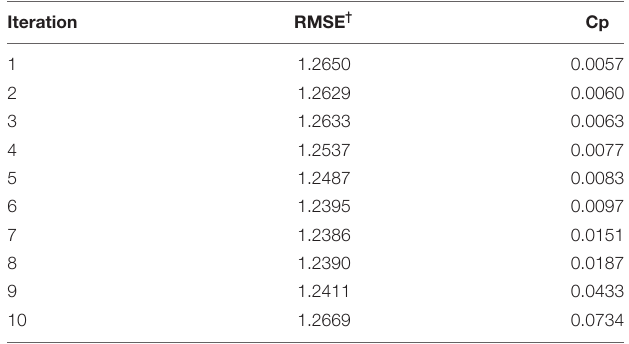
TABLE 4 | Modeling summary from the 10 iterations of the decision tree algorithm in R analyzing the seeding rate dataset ( n = 351).